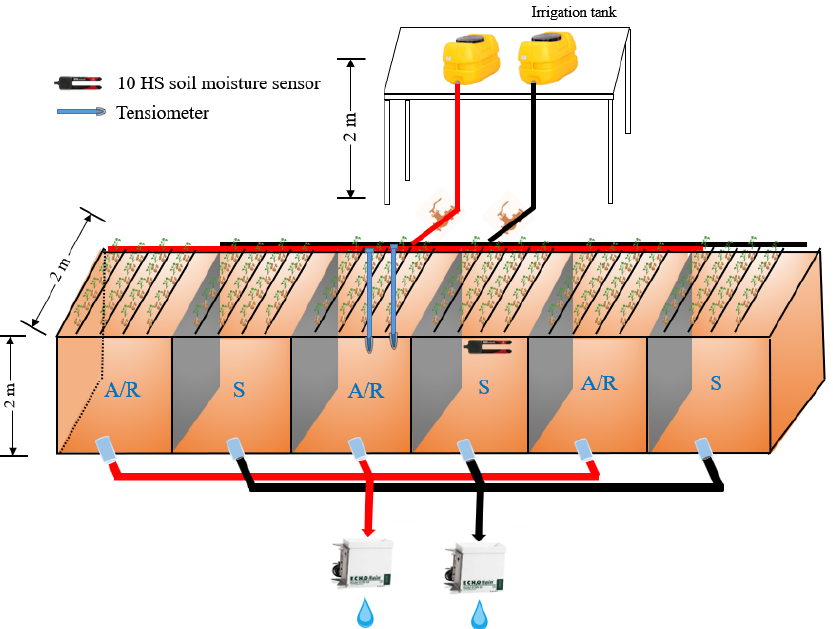
Figure 2. Hydraulic properties of Tottori sand in the experiment site.